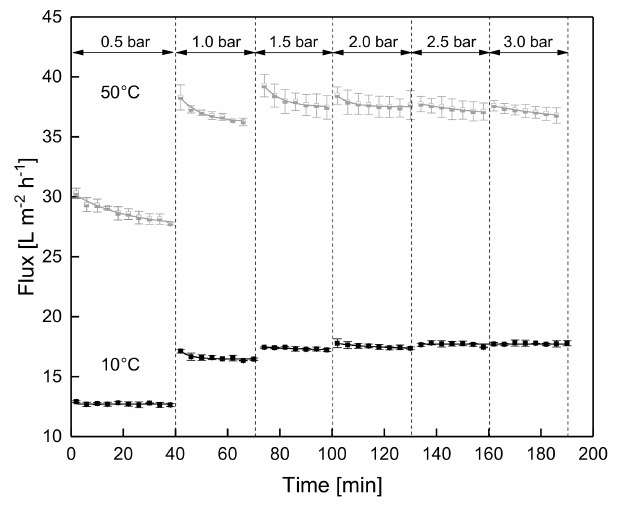
Figure 3. Flux as a function of filtration time during the stepwise increase of ∆ p TM at 10 ◦ C and 50 ◦